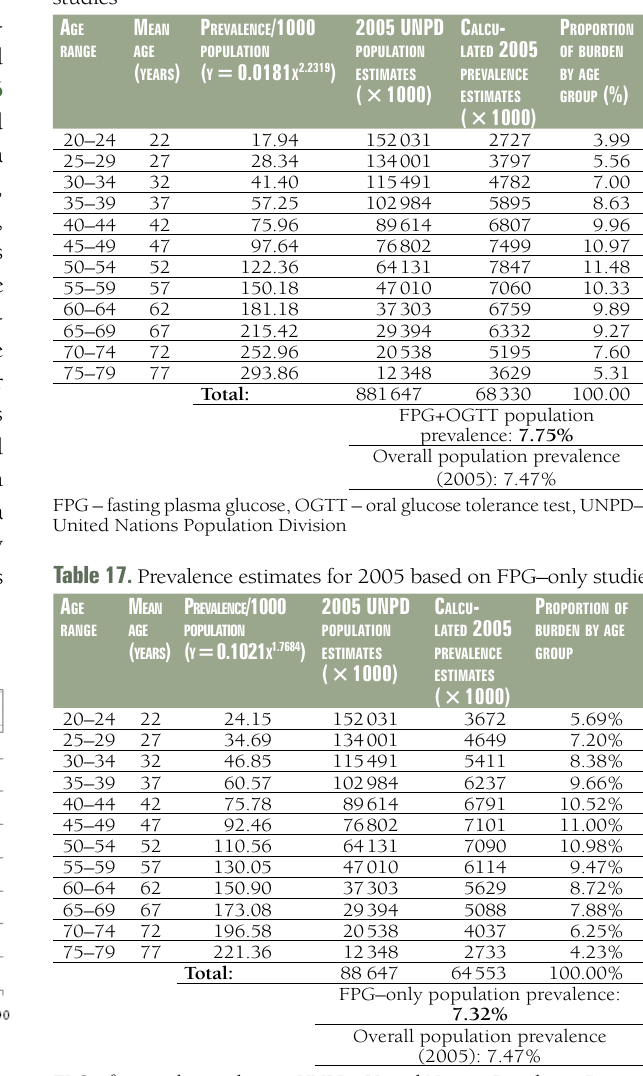
Table 16. Prevalence estimates for 2005 based on FPG+OGTT